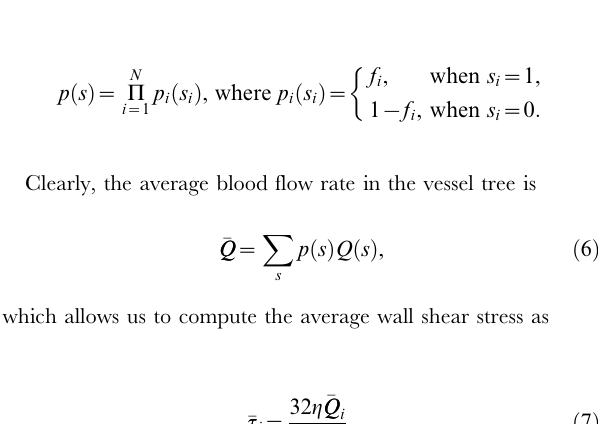
Þ denotes the open-close states